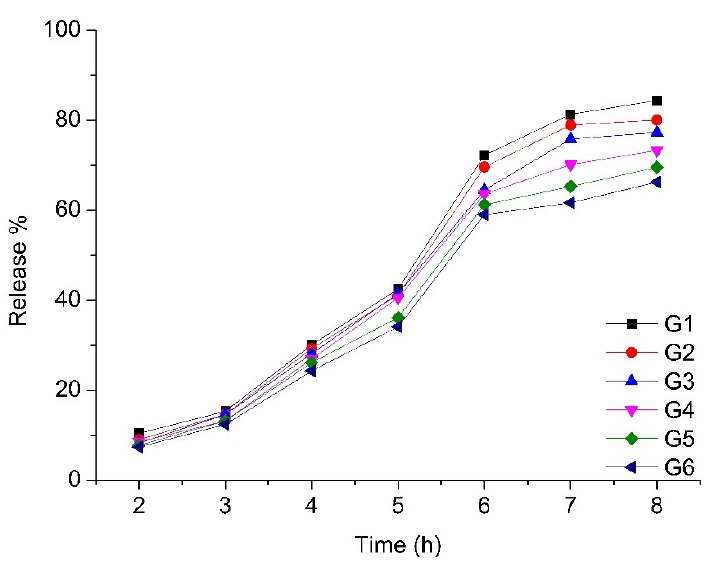
Figure 6. Percentage release of total phenolic compounds from experimental in situ gels G1–G6 after 8 h (mean ± SD, n = 3).